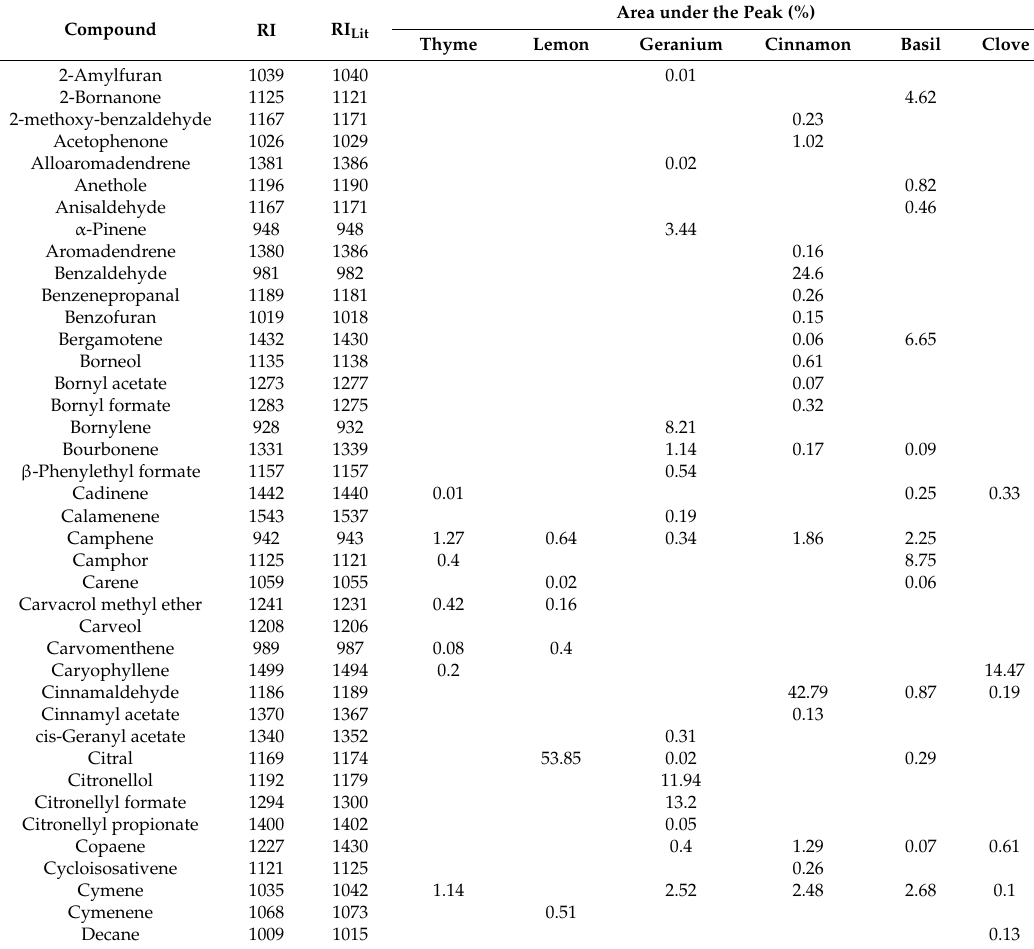
Table 8. Chemical composition of EOs tested obtained with GC × GC MS and content of each compound estimated from the area under the